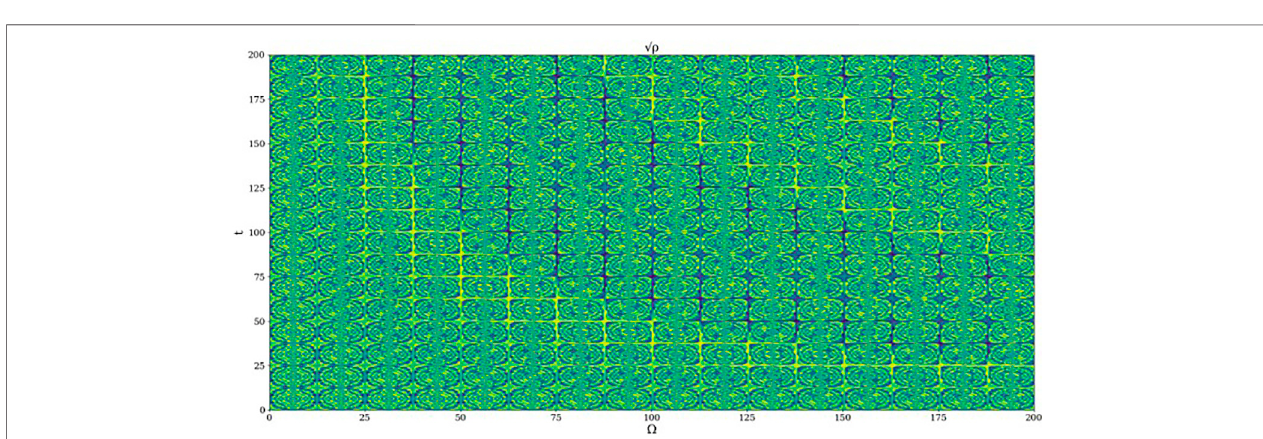
(cid:6) √ ρ ( Ω , t ) ; x (cid:2) 5, Φ (cid:2) 2 . 35.